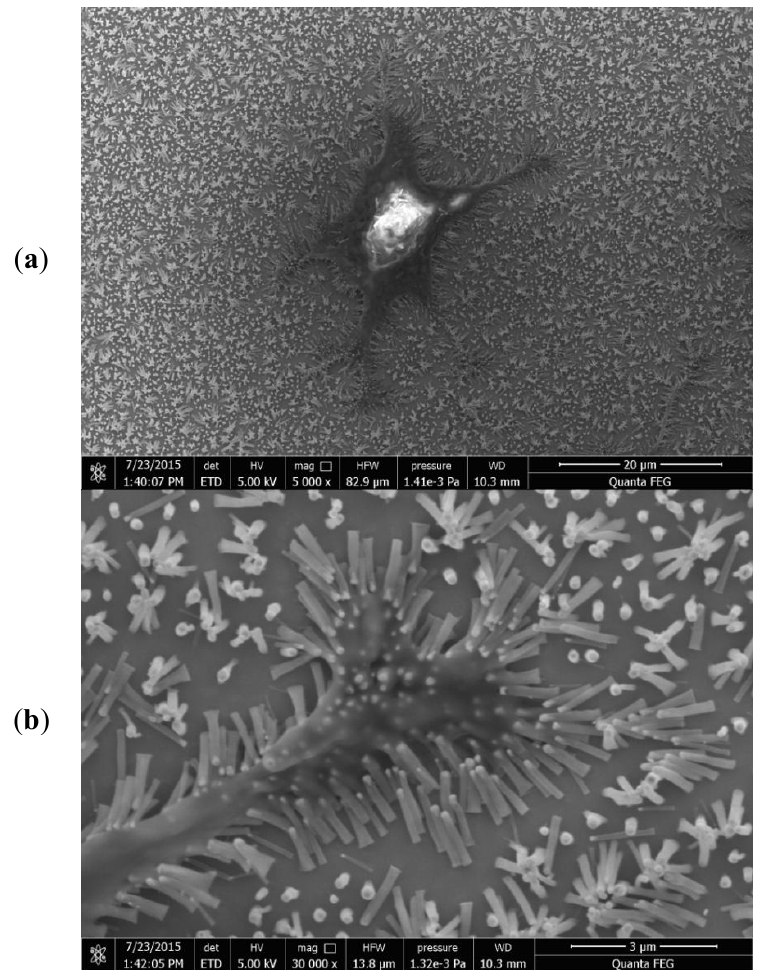
Figure 3. Chondrocyte was grown on perpendicularly aligned, chemical vapor deposition (CVD) synthesized multi-walled carbon nanotubes (MWCNTs), low magnification ( a ) and high magnification ( b ). Cytoplasmic extensions are visible. Note the cell adhesion to the scaffold. Phyllopodia bend the nanotubes to their purposes.